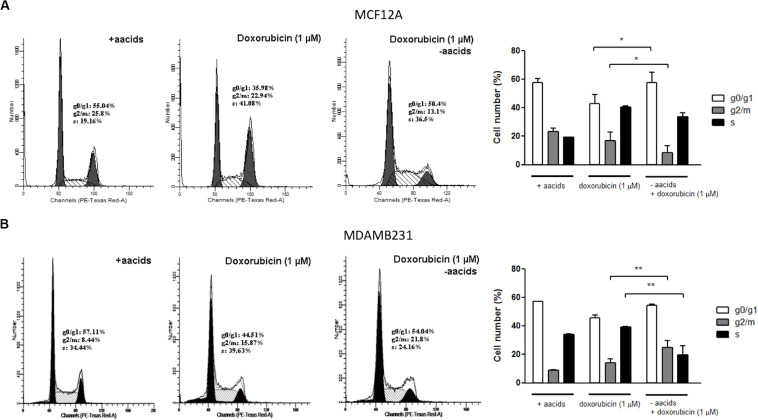
The effect of amino acid starvation and Dox treatment on the cells cycle of MCF12A and MDAMB231 cells. Representative DNA histograms and quantified bar graphs of cell cycle progression in MCF12A (A) and MDAMB231 (B) cells. Cell cycle progression was assessed using flow cytometry. Each value represents the mean ± SEM of at least three independent determinations. aacids, amino acids; *p < 0.05; **p < 0.01.